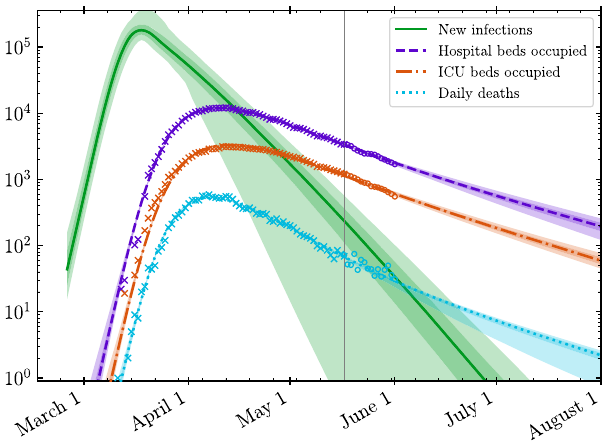
FIG. 10. Model fit and prediction for hospital and ICU bed occupancy [56,57] and deaths [58] in New York City using public data. Data from before the gray line on May 17, 2020 (crosses) are used for calibration. More recent data are plotted as circles. The model predictions shown here do not account for changes to mitigation after May 17,